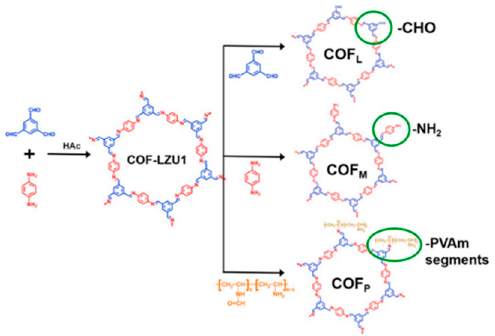
Figure 8. Synthesis process of functionalized COF L , COF M and COF P . Reprinted with permission from ref. [131]. Copyright 2020